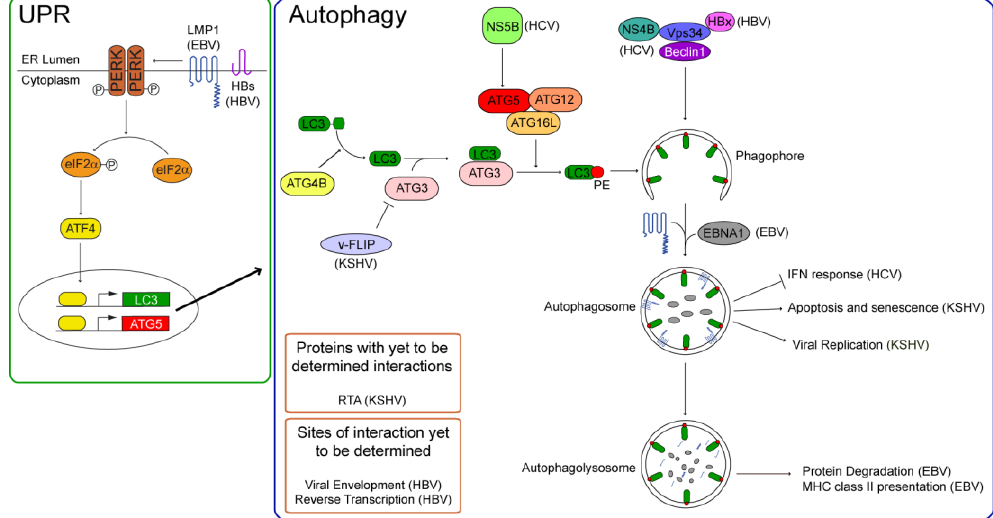
Figure 1. Autophagy is initiated by stimuli that activate the phosphatidylinositol 3-phosphate kinase, Vps34. Vps34 generates phosphatidylinositol 3-phosphate, a substrate for the forming autophagosome, and its enzymatic activity is dependent on Beclin 1. For its localization in the phagophore, the unclosed double-membrane precursor to the autophagosome, the light chain 3 (LC3) is conjugated to phosphatidylethanolamine (PE) via an ubiquitin-like conjugation pathway. LC3 is cleaved from its inactive precursor form by ATG4B to render it cytosolic, and subsequently conjugated to PE via its binding the E2-like ligase, autophagy related 3 homolog (ATG3), and its transfer to the E3-like ATG16L complex (ATG16L, ATG5, and ATG12). Autophagy can be stimulated via the Unfolded Protein Response (UPR) via the phosphorylation and activation of protein kinase RNA-like endoplasmic reticulum kinase (cid:11)(cid:51)(cid:40)(cid:53)(cid:46)(cid:12)(cid:17)(cid:3) (cid:36)(cid:70)(cid:87)(cid:76)(cid:89)(cid:72)(cid:3) (cid:51)(cid:40)(cid:53)(cid:46)(cid:3) (cid:83)(cid:75)(cid:82)(cid:86)(cid:83)(cid:75)(cid:82)(cid:85)(cid:92)(cid:79)(cid:68)(cid:87)(cid:72)(cid:86)(cid:3) (cid:87)(cid:75)(cid:72)(cid:3) (cid:72)(cid:88)(cid:78)(cid:68)(cid:85)(cid:92)(cid:82)(cid:87)(cid:76)(cid:70)(cid:3) (cid:76)(cid:81)(cid:76)(cid:87)(cid:76)(cid:68)(cid:87)(cid:76)(cid:82)(cid:81)(cid:3) (cid:73)(cid:68)(cid:70)(cid:87)(cid:82)(cid:85)(cid:3) (cid:21)(cid:3) (cid:68)(cid:79)(cid:83)(cid:75)(cid:68)(cid:3) (cid:11)(cid:72)(cid:44)(cid:41)(cid:21)(cid:302)(cid:12)(cid:17)(cid:3) Phospho- (cid:72)(cid:44)(cid:41)(cid:21)(cid:302)(cid:3) (cid:70)(cid:68)(cid:81)(cid:81)(cid:82)(cid:87)(cid:3) (cid:87)(cid:85)(cid:68)(cid:81)(cid:86)(cid:79)(cid:68)(cid:87)(cid:72)(cid:3) (cid:70)(cid:68)(cid:83)(cid:83)(cid:72)(cid:71)(cid:3) (cid:80)(cid:53)(cid:49)(cid:36)(cid:86)(cid:15)(cid:3) (cid:69)(cid:88)(cid:87)(cid:3) (cid:70)(cid:68)(cid:81)(cid:3) (cid:87)(cid:85)(cid:68)(cid:81)(cid:86)(cid:79)(cid:68)(cid:87)(cid:72)(cid:3) (cid:80)(cid:53)(cid:49)(cid:36)(cid:86)(cid:3) (cid:90)(cid:76)(cid:87)(cid:75)(cid:3) (cid:76)(cid:81)(cid:87)(cid:72)(cid:85)(cid:81)(cid:68)(cid:79)(cid:3) ribosome entry sites (IRES), such as activated transcription factor 4 (ATF4). ATF4 activates the transcription of LC3 and Beclin 1 to induce autophagy. Human tumor viruses can regulate autophagy at several steps of the pathway. Both latent membrane protein 1 (LMP1) and the small surface protein of HBV (HBs) st (cid:76)(cid:80)(cid:88)(cid:79)(cid:68)(cid:87)(cid:72)(cid:3) (cid:87)(cid:75)(cid:72)(cid:3) (cid:56)(cid:51)(cid:53)(cid:3) (cid:68)(cid:81)(cid:71)(cid:3) (cid:76)(cid:81)(cid:71)(cid:88)(cid:70)(cid:72)(cid:3) (cid:68)(cid:88)(cid:87)(cid:82)(cid:83)(cid:75)(cid:68)(cid:74)(cid:92)(cid:17)(cid:3) (cid:47)(cid:48)(cid:51)(cid:20)(cid:182)(cid:86)(cid:3) induction of autophagy regulates its degradation in autophagolysosomes. The Epstein-Barr nuclear antigen 1 (EBNA1) also can localize to autophagosomes and is degraded in autophagolysosomes, where epitopes of EBNA1 are generated for their presentation on MHC (cid:70)(cid:79)(cid:68)(cid:86)(cid:86)(cid:3) (cid:44)(cid:44)(cid:3) (cid:80)(cid:82)(cid:79)(cid:72)(cid:70)(cid:88)(cid:79)(cid:72)(cid:86)(cid:17)(cid:3) (cid:36)(cid:88)(cid:87)(cid:82)(cid:83)(cid:75)(cid:68)(cid:74)(cid:92)(cid:3) (cid:73)(cid:82)(cid:86)(cid:87)(cid:72)(cid:85)(cid:86)(cid:3) (cid:43)(cid:37)(cid:57)(cid:182)(cid:86)(cid:3) (cid:83)(cid:85)(cid:82)(cid:71)(cid:88)(cid:70)(cid:87)(cid:76)(cid:89)(cid:72)(cid:3) (cid:76)(cid:81)(cid:73)(cid:72)(cid:70)(cid:87)(cid:76)(cid:82)(cid:81)(cid:17)(cid:3) (cid:44)(cid:81)(cid:3) (cid:68)(cid:71)(cid:71)(cid:76)(cid:87)(cid:76)(cid:82)(cid:81)(cid:3) (cid:87)(cid:82)(cid:3) (cid:43)(cid:37)(cid:86)(cid:15)(cid:3) (cid:87)(cid:75)(cid:72)(cid:3) Hepatitis B X protein (HBx) can stimulate autophagy via its interaction with Vps34. (cid:36)(cid:88)(cid:87)(cid:82)(cid:83)(cid:75)(cid:68)(cid:74)(cid:92)(cid:3) (cid:70)(cid:68)(cid:81)(cid:3) (cid:86)(cid:88)(cid:83)(cid:83)(cid:82)(cid:85)(cid:87)(cid:3) (cid:43)(cid:37)(cid:57)(cid:182)(cid:86)(cid:3) (cid:72)(cid:81)(cid:89)(cid:72)(cid:79)(cid:82)(cid:83) ment or reverse transcription. The non-structural proteins of HCV, NS4B and NS5B induce autophagy; the former appears to interact with (cid:57)(cid:83)(cid:86)(cid:22)(cid:23)(cid:15)(cid:3) (cid:90)(cid:75)(cid:76)(cid:79)(cid:72)(cid:3) (cid:87)(cid:75)(cid:72)(cid:3) (cid:79)(cid:68)(cid:87)(cid:87)(cid:72)(cid:85)(cid:3) (cid:83)(cid:85)(cid:82)(cid:80)(cid:82)(cid:87)(cid:72)(cid:86)(cid:3) (cid:47)(cid:38)(cid:22)(cid:182)(cid:86)(cid:3) (cid:70)(cid:82)(cid:81)(cid:77)(cid:88)(cid:74)(cid:68)(cid:87)(cid:76)(cid:82)(cid:81)(cid:3) (cid:87)(cid:82)(cid:3) (cid:51)(cid:40)(cid:3) (cid:69)(cid:92)(cid:3) (cid:69)(cid:76)(cid:81)(cid:71)(cid:76)(cid:81)(cid:74)(cid:3) (cid:36)(cid:55)(cid:42)(cid:24)(cid:17)(cid:3) (cid:36)(cid:88)(cid:87)(cid:82)(cid:83)(cid:75)(cid:68)(cid:74)(cid:92)(cid:3) inhibits the cellular interferon resp (cid:82)(cid:81)(cid:86)(cid:72)(cid:3)(cid:71)(cid:88)(cid:85)(cid:76)(cid:81)(cid:74)(cid:3)(cid:87)(cid:75)(cid:72)(cid:3)(cid:72)(cid:68)(cid:85)(cid:79)(cid:92)(cid:3)(cid:86)(cid:87)(cid:68)(cid:74)(cid:72)(cid:86)(cid:3)(cid:82)(cid:73)(cid:3)(cid:43)(cid:38)(cid:57)(cid:182)(cid:86)(cid:3)(cid:76)(cid:81)(cid:73)(cid:72)(cid:70)(cid:87)(cid:76)(cid:82)(cid:81)(cid:17)(cid:3)(cid:44)(cid:81)(cid:3)(cid:70)(cid:82)(cid:81)(cid:87)(cid:85)(cid:68)(cid:86)(cid:87)(cid:3) to NS5B, the KSHV viral FADD-like interleukin-1 beta-converting enzyme inhibitory protein (v- (cid:41)(cid:47)(cid:44)(cid:51)(cid:12)(cid:3) (cid:76)(cid:81)(cid:75)(cid:76)(cid:69)(cid:76)(cid:87)(cid:86)(cid:3) (cid:47)(cid:38)(cid:22)(cid:182)(cid:86)(cid:3) (cid:79)(cid:76)(cid:83)(cid:76)(cid:71) -conjugation by competing with it for ATG3. v-FLIP inhibits autophagy-induced apoptosis and senescence of KSHV-positive cells. Autophagy is (cid:76)(cid:81)(cid:71)(cid:88)(cid:70)(cid:72)(cid:71)(cid:3)(cid:69)(cid:92)(cid:3)(cid:85)(cid:72)(cid:83)(cid:79)(cid:76)(cid:70)(cid:68)(cid:87)(cid:76)(cid:82)(cid:81)(cid:3)(cid:68)(cid:81)(cid:71)(cid:3)(cid:87)(cid:85)(cid:68)(cid:81)(cid:86)(cid:68)(cid:70)(cid:87)(cid:76)(cid:89)(cid:68)(cid:87)(cid:82)(cid:85)(cid:3)(cid:11)(cid:53)(cid:55)(cid:36)(cid:12)(cid:3)(cid:87)(cid:82)(cid:3)(cid:86)(cid:88)(cid:83)(cid:83)(cid:82)(cid:85)(cid:87)(cid:3)(cid:46)(cid:54)(cid:43)(cid:57)(cid:182)(cid:86)(cid:3)(cid:85)(cid:72)(cid:83)(cid:79)(cid:76)(cid:70)(cid:68)(cid:87)(cid:76)(cid:82)(cid:81)(cid:15)(cid:3)(cid:68)(cid:81)(cid:71)(cid:3)(cid:89) -FLIP may inhibit the productive life-cycle of the virus by repressing